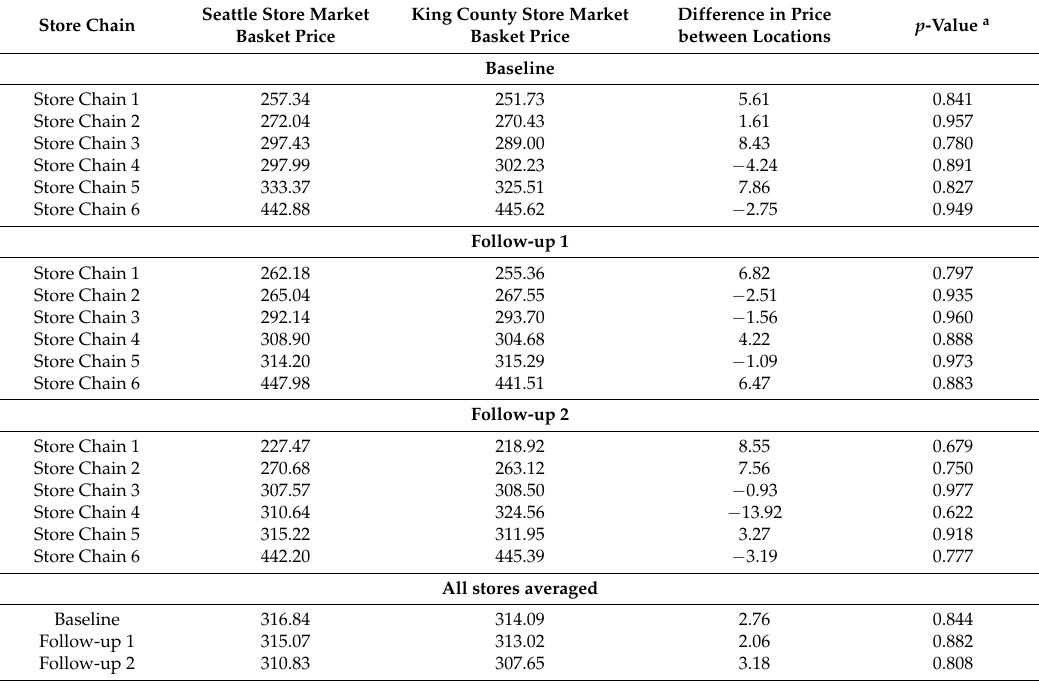
Table 1. Comparison of total market basket price, by supermarket chain and location, at baseline, follow-up 1, and follow-up 2.